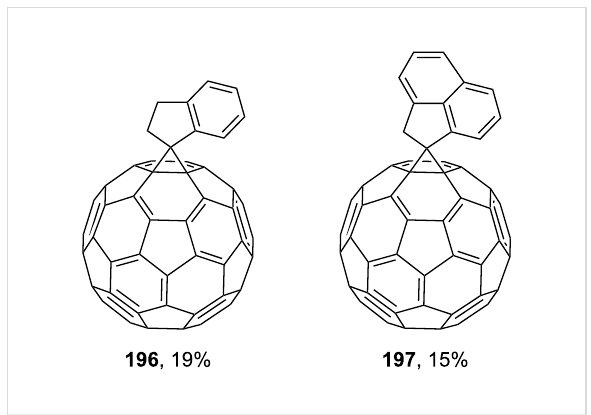
Figure 14: Dibenzosuberane-substituted fullerene derivatives 196 and 197